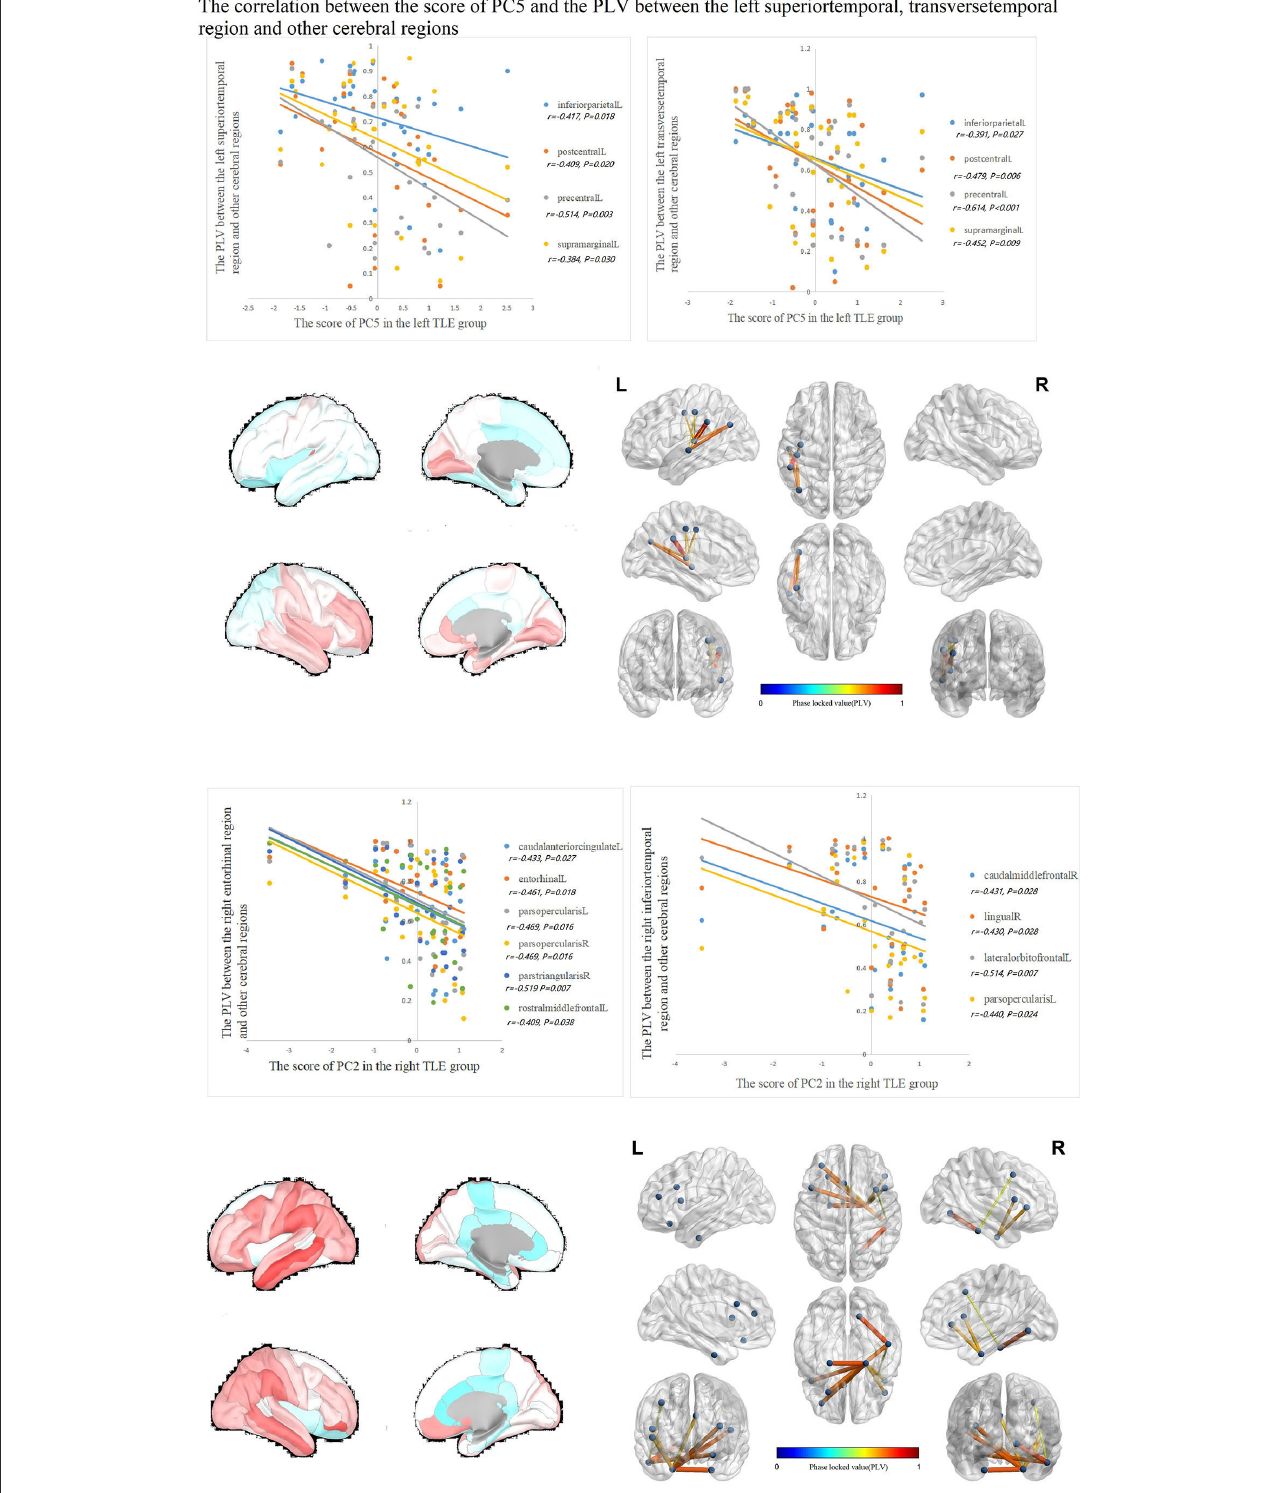
FIGURE5 In the left TLE group, the IED source connectivity between the left temporal lobe and the rolandic, parietal cortex was negatively correlated with SC4. In the right TLE group, the IED source connectivity between the right temporal lobe and the frontal, temporal regions was negatively correlated with SC4.